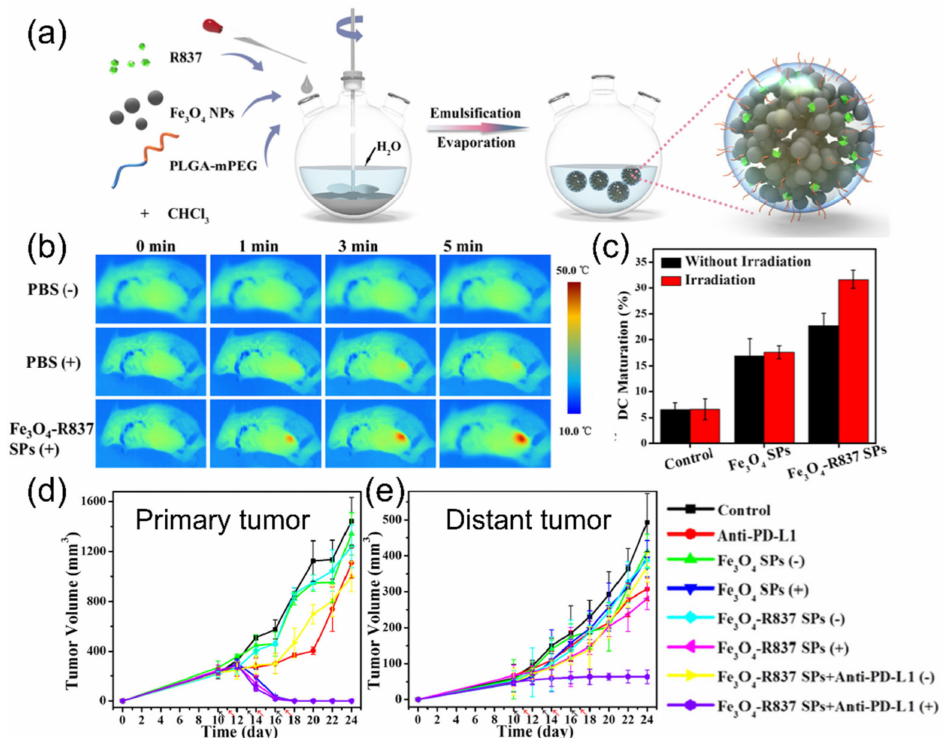
Figure 5. ( a ) Schematic illustration of iron oxide nanoparticles for immunotherapy against 4T1 models; ( b ) thermal images of 4T1 tumor-bearing mice after laser irradiation; ( c ) change of dendritic cell maturation after the treatment; ( d , e ) tumor growth curves of the primary ( d ) and metastatic tumors ( e ). Figures are reproduced from ref. [83] with permission from the American Chemical